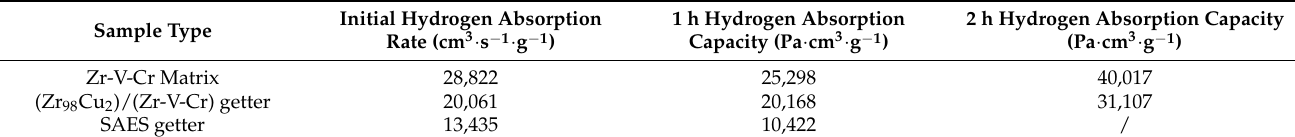
Figure 5. Comparison of hydrogen absorption performance between Zr-V-Cr matrix, (Zr 98 Cu 2 )/(Zr- V-Cr) getter, and SAES getter. Table 4. Comparison of hydrogen absorption performance of Zr-V-Cr matrix, (Zr 98 Cu 2 )/(Zr-V-Cr) getter, and SAES getter.